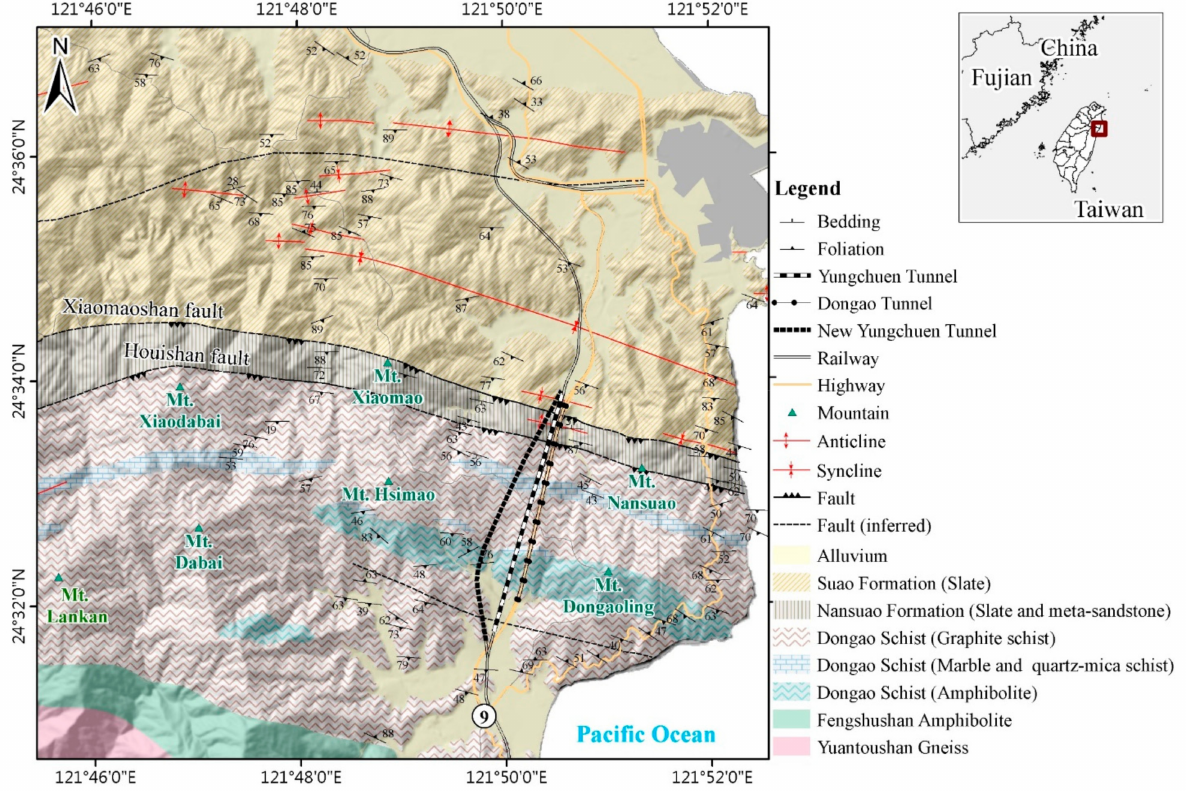
Figure 2. Geological map of the study area